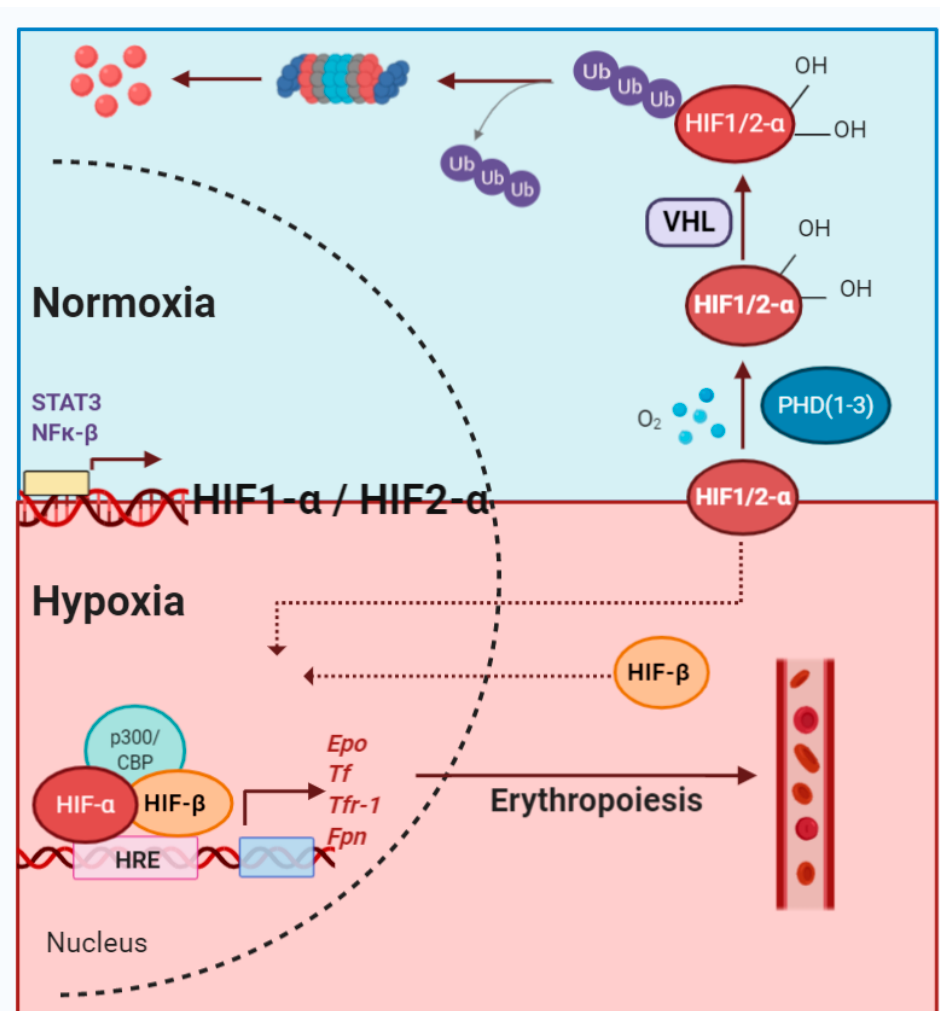
Figure 1. Schematic overview of the hypoxia pathway under normoxia and hypoxia. The hypoxia-inducible factor (HIF)- α subunits are synthesized and subsequently degraded under normoxia (blue). In the presence of physiological oxygen levels, prolyl hydroxylase domain proteins (PHDs) mediate hydroxylation of HIFs, leading to subsequent binding to von Hippel–Lindau tumor suppressor protein (VHL). VHL facilitates the ubiquitination of hydroxylated HIFs, resulting in proteasomal degradation. However, under hypoxia (red), the hydroxylation of the alpha subunits is inhibited, stabilizing the HIF- α subunits. The stabilized alpha subunits bind to the beta subunit and translocate to the nucleus. The HIFs, together with other cofactors, bind hypoxia response elements (HREs), promoting the transcription of genes essentially involved in erythropoiesis. Created with Biorender.com